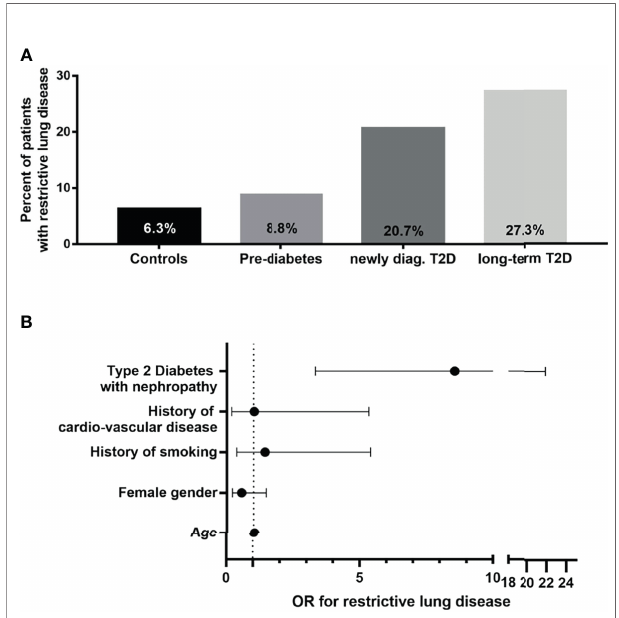
FIGURE 1 | Clinical characterization of diabetic patients with restrictive lung disease. (A) Percentages of patients with restrictive lung disease shown in bar graphs according to group [as shown (5)]. (B) Calculated odds ratios (OR) with 95% con fi dence interval for restrictive lung disease plotted on x-axis for selected clinical parameters in patients with type 2 diabetes and albuminuria as compared to non-diabetic patients [modi fi ed as described earlier (5)].T2D, type 2 diabetes; OR, odds